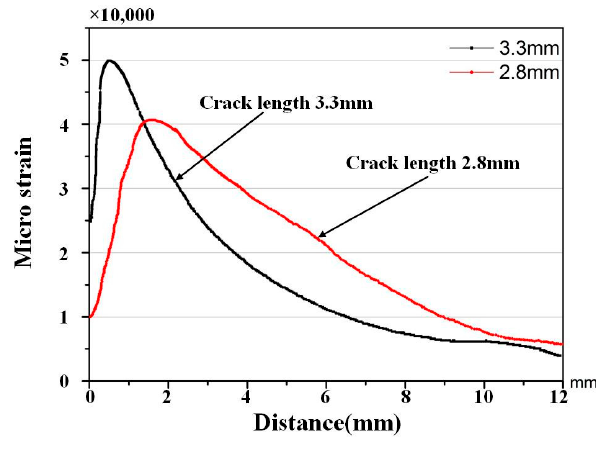
Figure 12. Strain value along the grating with crack lengths of 2.8 and 3.3 mm.